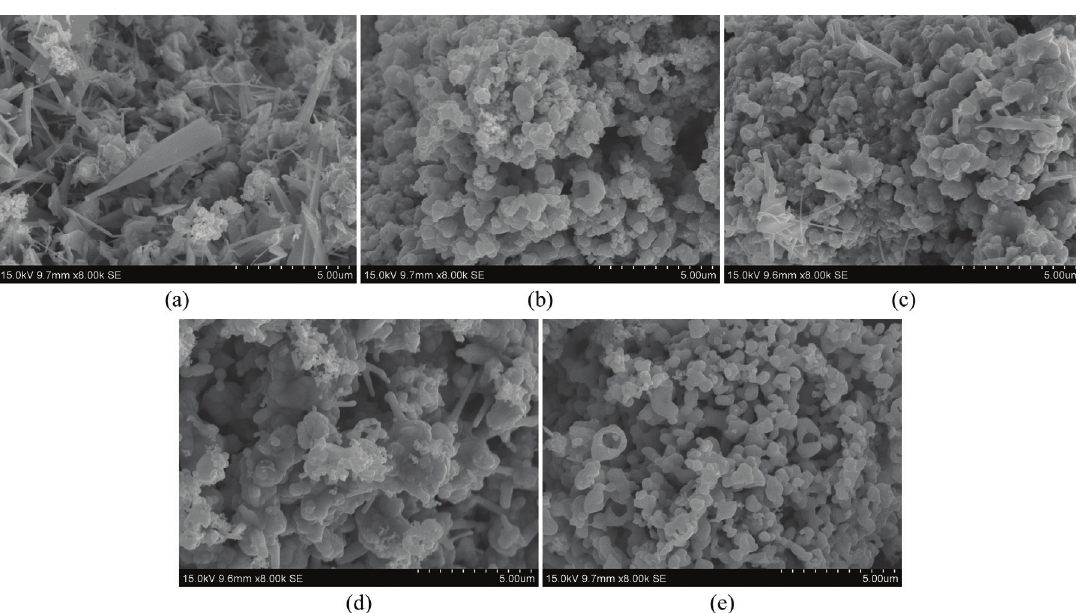
Figure 3. SEM micrographs of ZnO particles oxidized from Zn nanoparticles at different temperatures. (a) 500 °C, (b) 600 °C, (c) 700 °C, (d) 800 °C and (e) 900 °C.